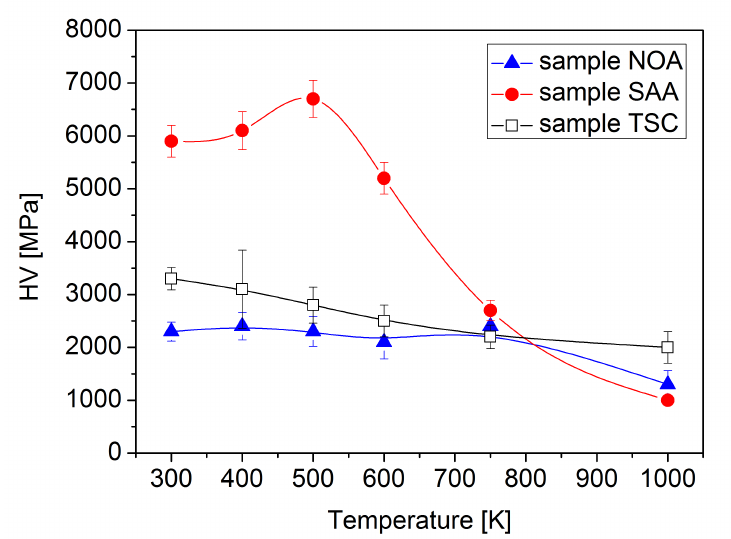
Figure 10. The Vickers microhardness of the three samples versus the temperature of the heat treatment. The curves are only for guidance and do not represent any fitting